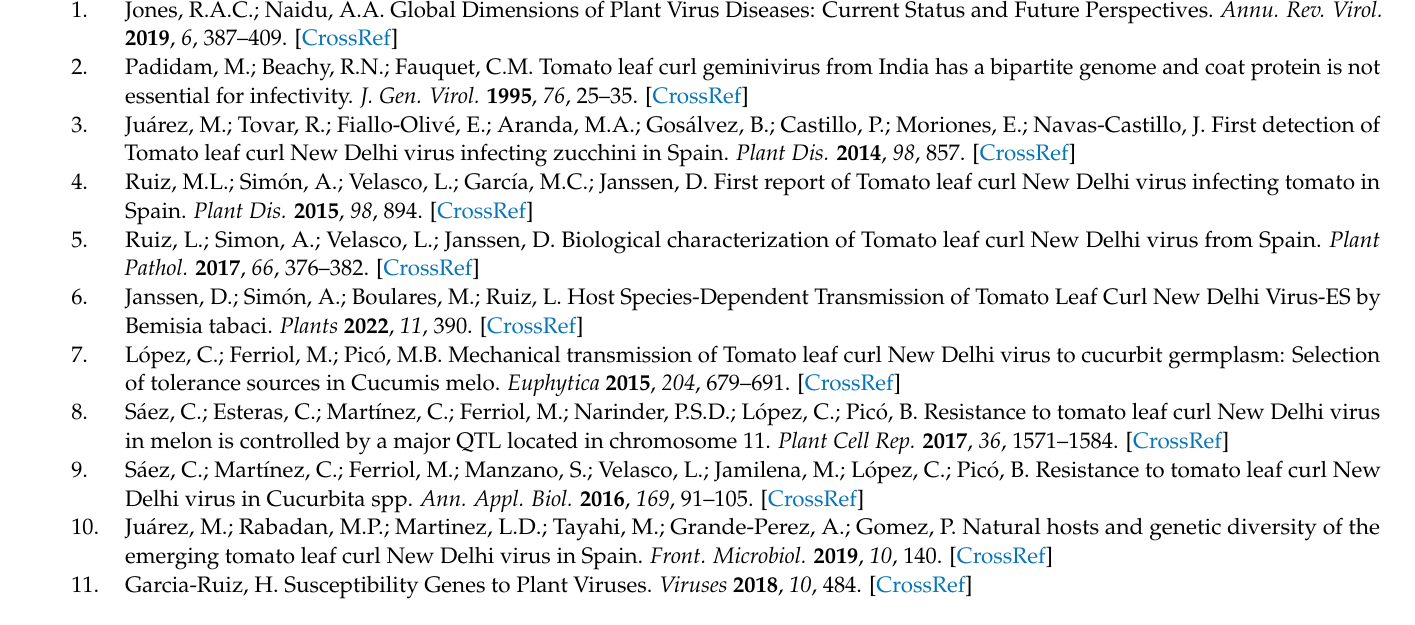
four plants. Figure S2: Expression profile of TORTIFOLIA (a), PELOTA (b), SGS1 (c), SGS2 (d), AGO (e), RDR1 (f), RDR6 (g) NIK1 (h) and SYTA (i) genes in C. melo accessions ToLCNDV inoculated at 0, 3, 6, 10 and 15 dpi. Figure S3: Expression profile of TORTIFOLIA (a), PELOTA (b), SGS1 (c), SGS2 (d), AGO (e), RDR1 (f), RDR6 (g) NIK1 (h) and ARP4 (i) genes in C. moschata accessions ToLCNDV inoculated at 0, 3, 6, 10 and 15